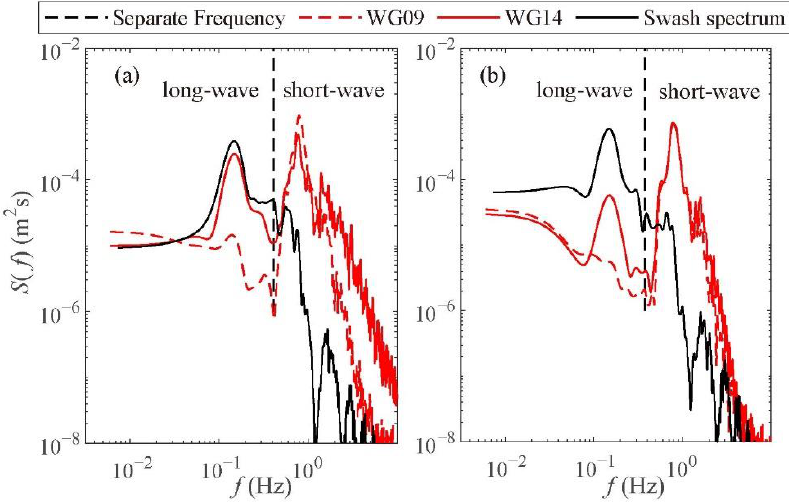
Figure 5. ( a ) Wave spectrum evolution of experiment case T00 under the water depth of 0.42 m. ( b ) Wave spectrum evolution of experiment case T01 under the water depth of 0.45 m. The black dash line is the separation frequency of short-wave and long-wave. WG09 (red dash line) is located before wave breaking and WG14 (red solid line) is located nearshore.